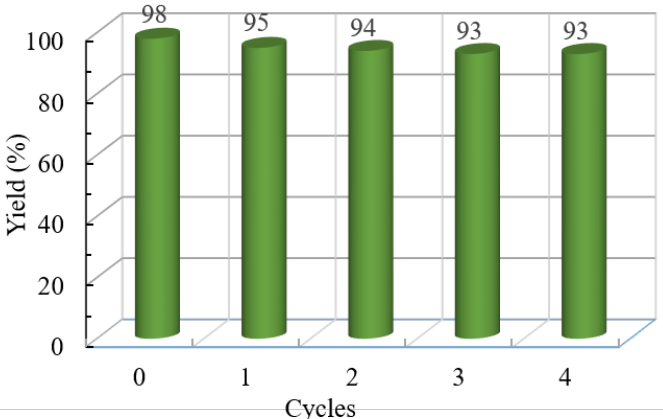
Figure 5. Reuse of Cu@N-C(600) catalyst. Table 4. The Cu leaching of Cu@N-C(600) catalyst.